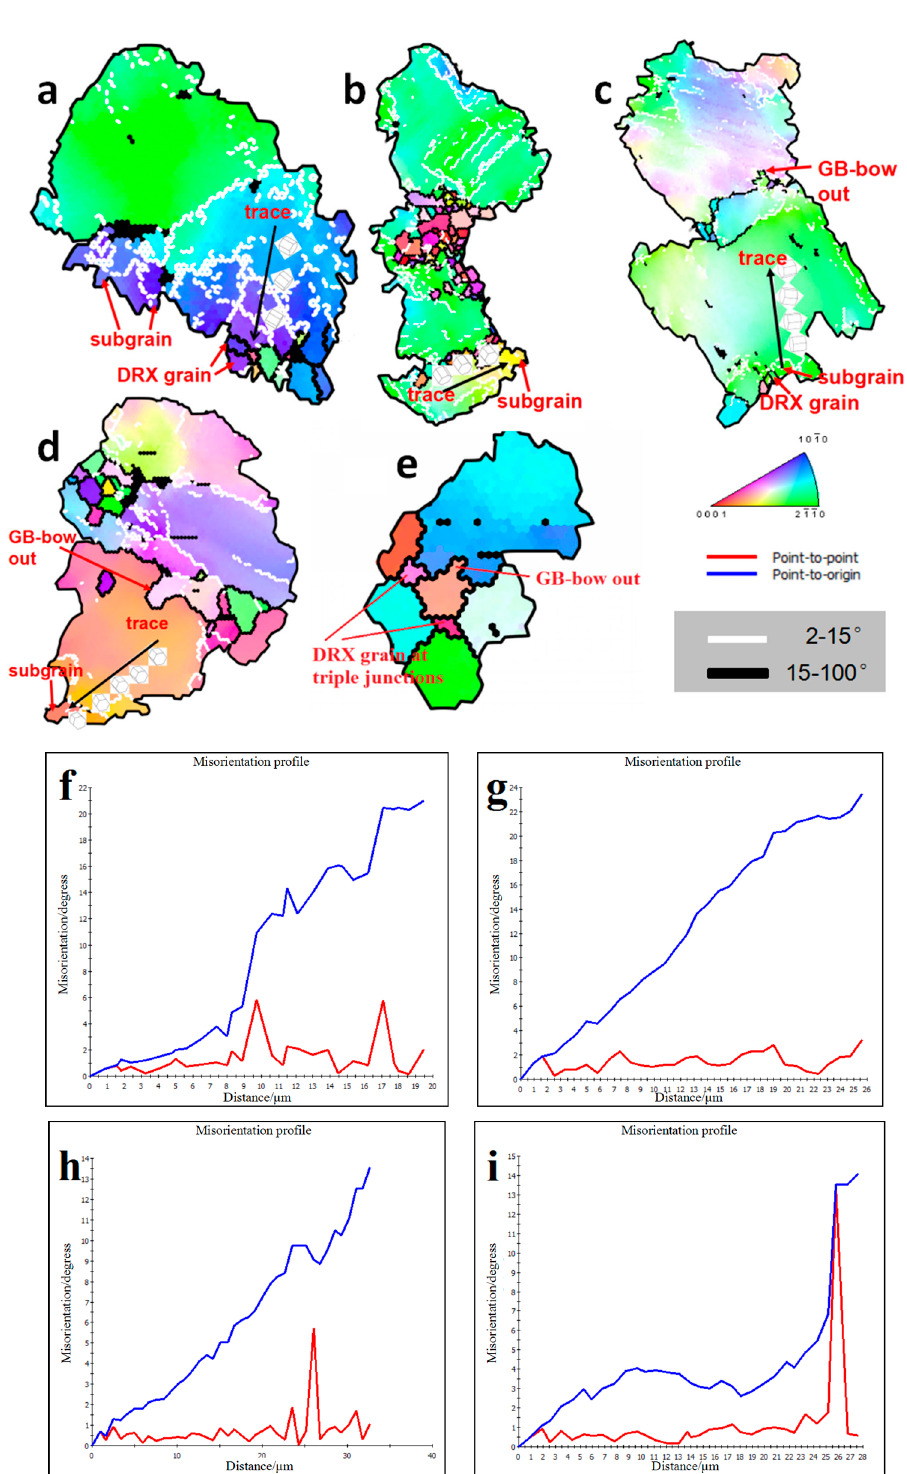
Figure 6. ( a – e ) An enlarged map of the selected area from Figure 5a–d; ( f – i ) the misorientation profiles measured along the trace in a–e,